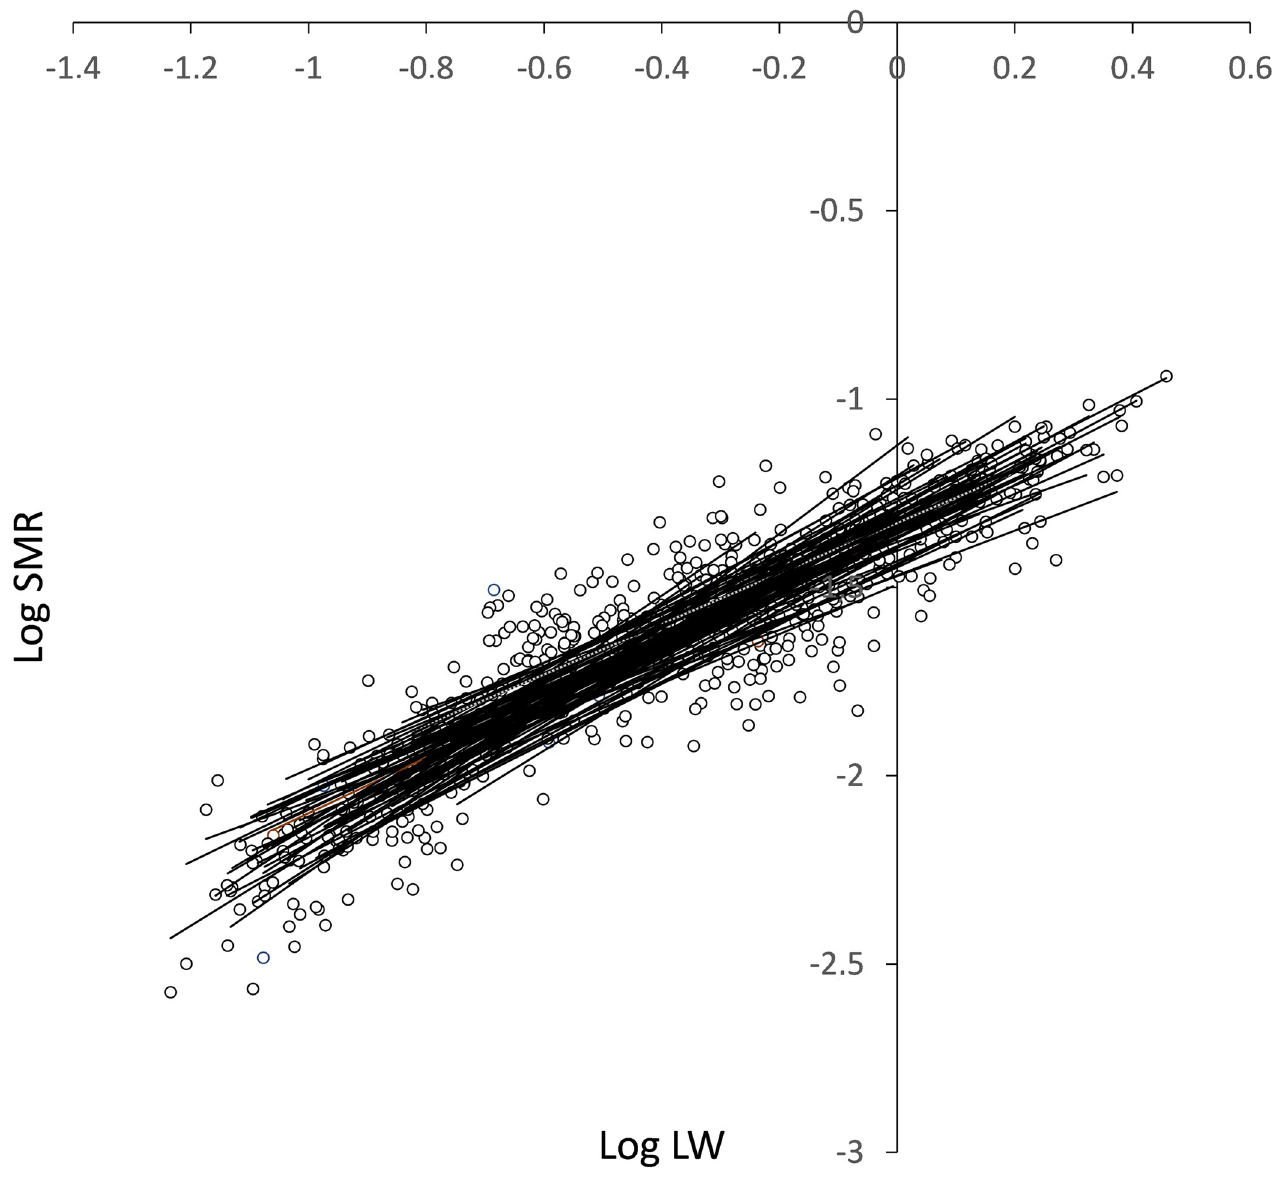
Fig 4. Regression lines fitted to log-log transformed data of SMR (ml O 2 h -1 ) vs LW (g) in 100 individuals. Size ranges correspond to the weight increment experienced by each individual mussel. Only 5 of these regressions were not significant (P > 0.05). https://doi.org/10.1371/journal.pone.0268053.g004 Table 1. Analysis of covariance (ANCOVA) of intra-individual SMR vs LW